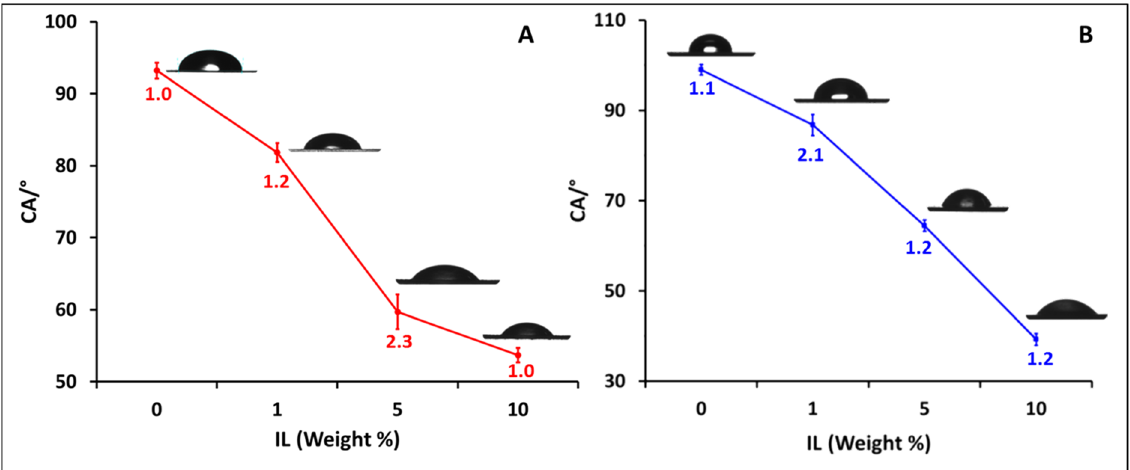
Figure 15. Water contact angle of ( A ) neat PVC and PVC/HdmimDMSIP blends, ( B ) neat SEBS and SEBS/HdmimDMSIP blends. Points are the mean of three independent replicates with n = 3 each. The points representing the CA values from PVC/1% IL and SEBS/1% IL blends had significantly different results from the related ones from both PVC and SEBS blends loaded with 5–10% of IL at p < 0.0001 (one-way ANOVA and Tukey test). The same result ( p < 0.0001) was found when comparing the CA values from the IL blends with the related controls (neat polymers). Bars and numbers close to them represent ± SD.